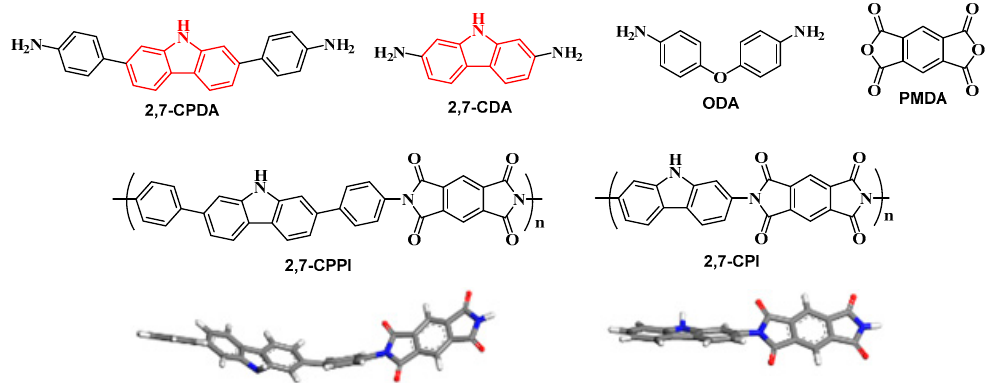
Figure 1. The chemical structure of 2,7 ‐ CPDA, 2,7 ‐ CDA, ODA, and PMDA and the stereo view of the lowest energy conformation of repeat units for 2,7 ‐ CPPI and 2,7 ‐ CPI.